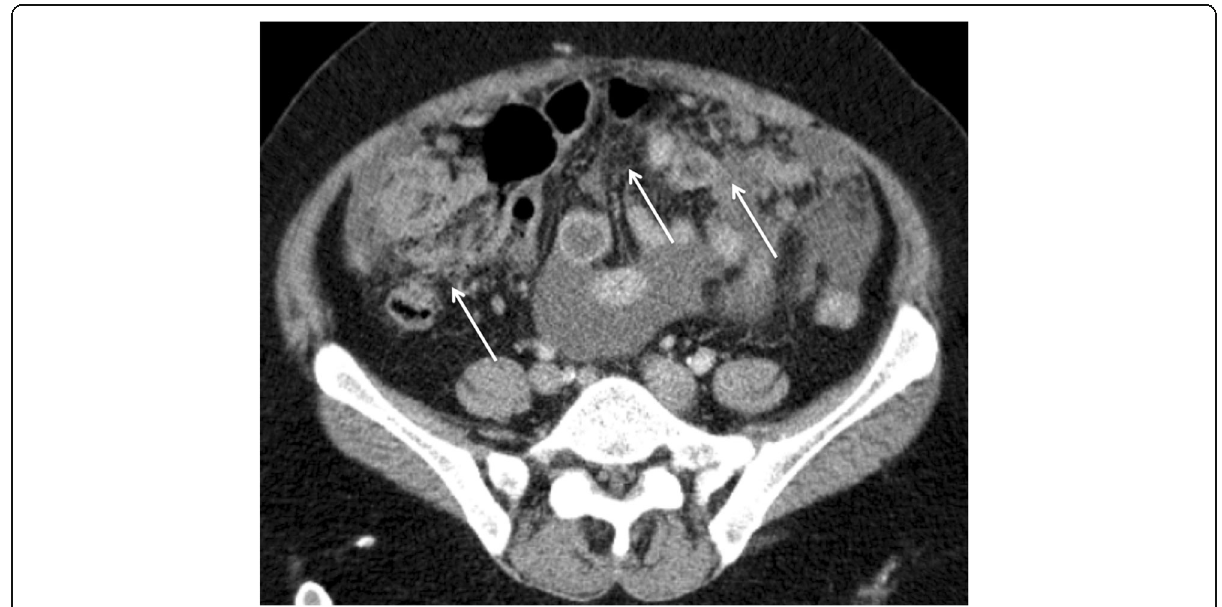
Fig. 2 Axial CT post-contrast image of the pelvis showing pelvic effusion and an infiltrative peritoneal metastasis pattern, no individualized peritoneal nodules were visualized in a BRCA-wild type patient